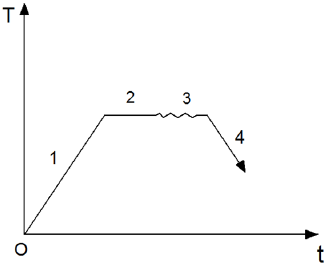
Figure 2. Original cylindrical specimen.